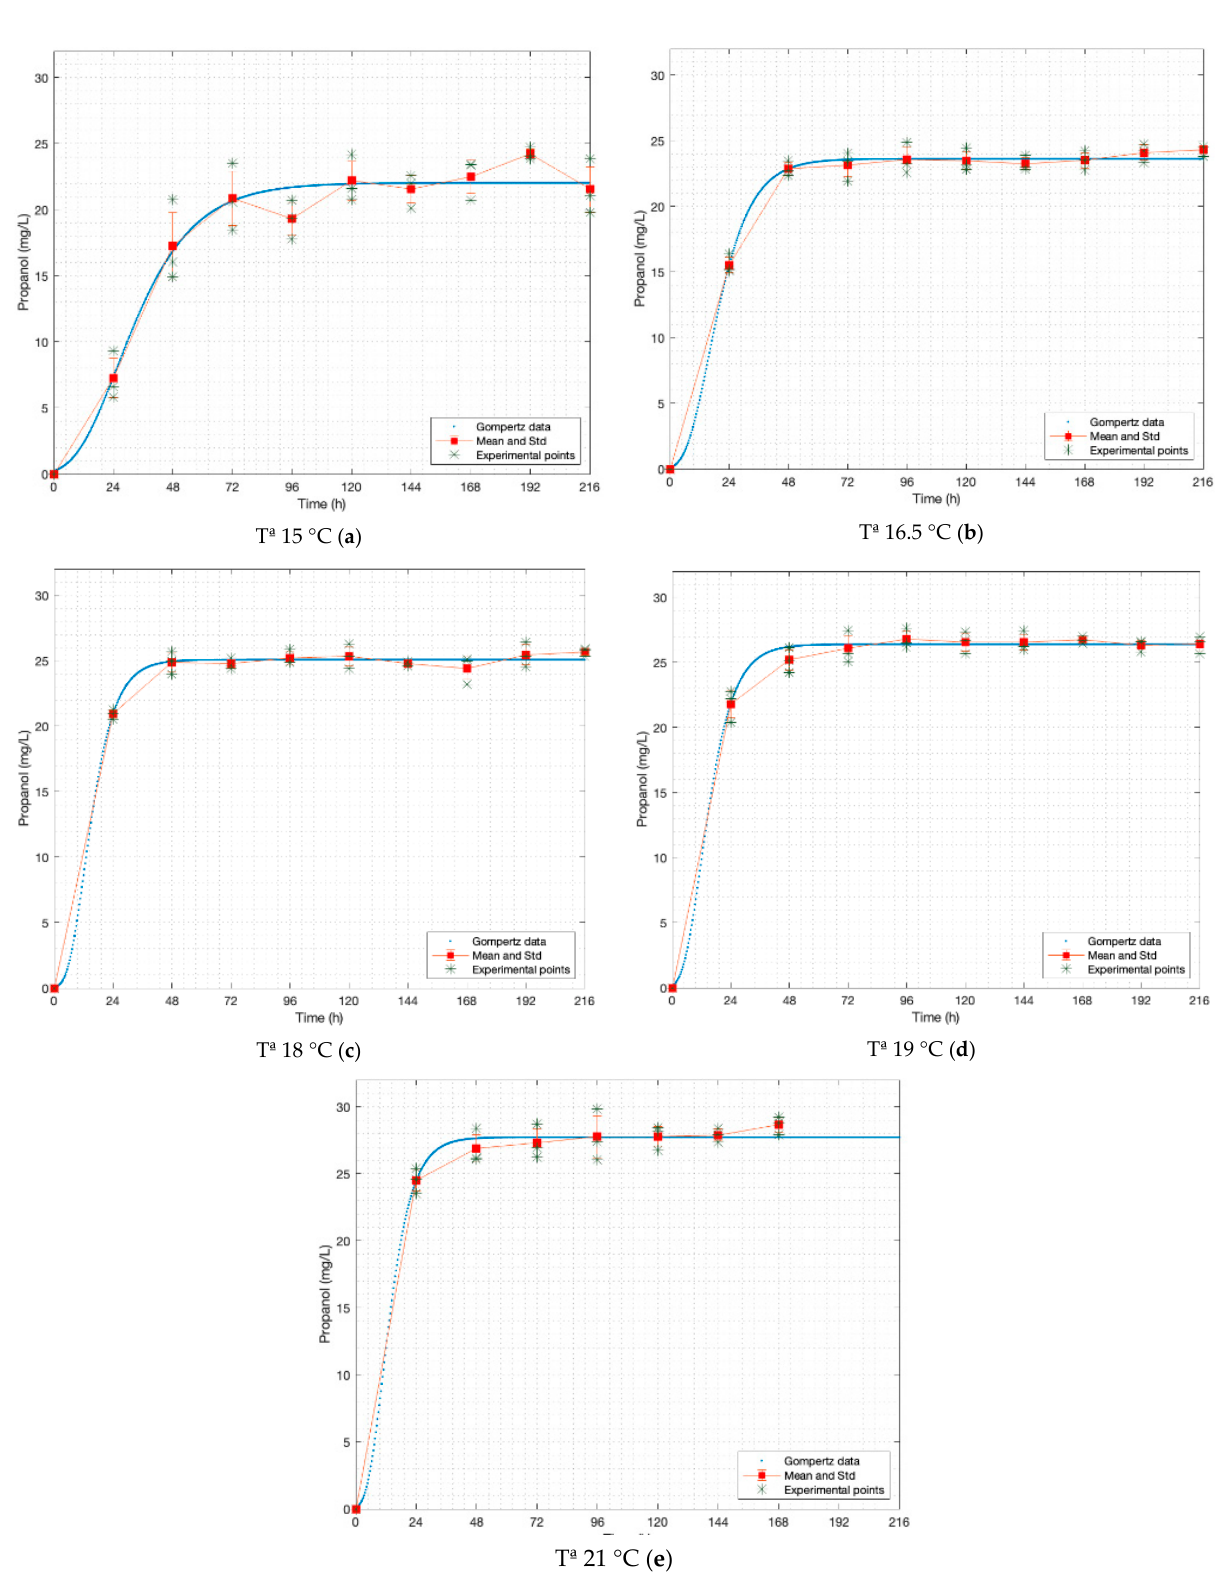
Figure 4. Gompertz graphs of predicted values for amyl alcohol. ( a ) Dataset 15 °C; ( b ) dataset 16.5 °C; ( c ) dataset 18 °C; ( d ) dataset 19 °C; ( e ) dataset 21 °C. Blue lines represent the Gompertz function. Asterisk represents experimental raw data. Squares and red lines represent the means and standard deviations.